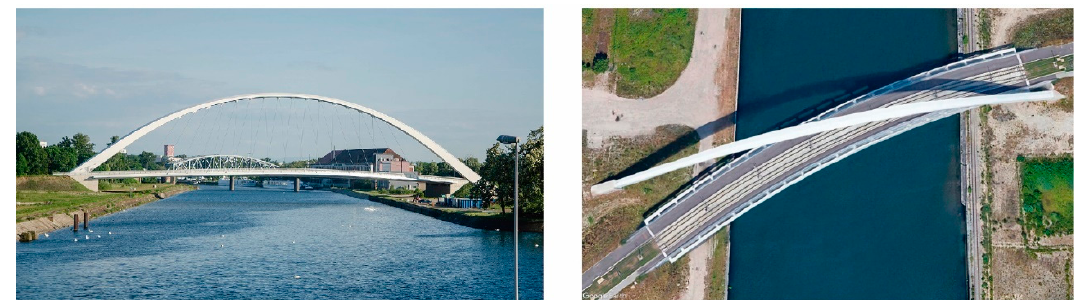
Figure 17. Pont André-Bord (photos: Valentin R, Wikimedia Commons ( left ) and Google Earth ( right )).